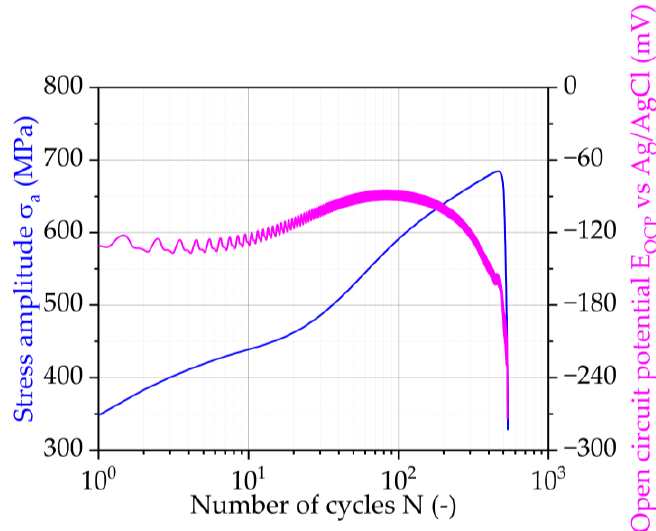
Figure 5. Open circuit potential E OCP results of one CAT at RT with 𝜀 𝑎,𝑡 = 1.46%.